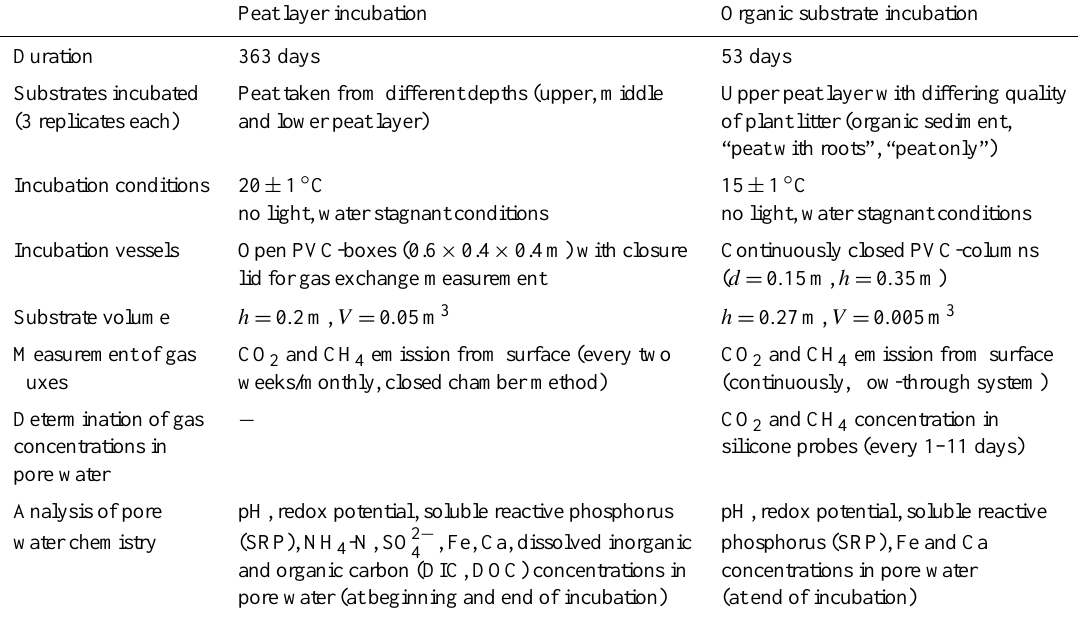
Table 2. Overview of the two incubations